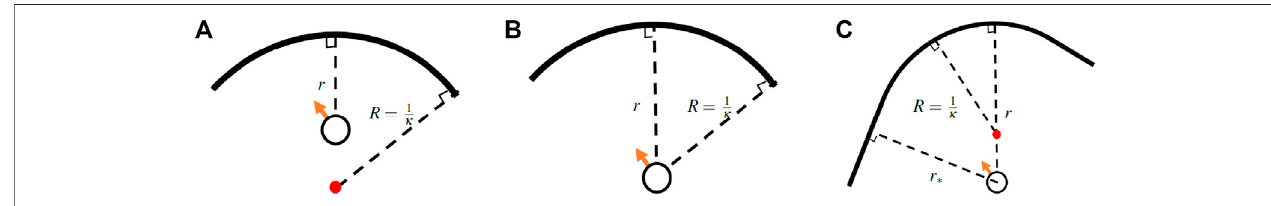
, and (C) the case where r